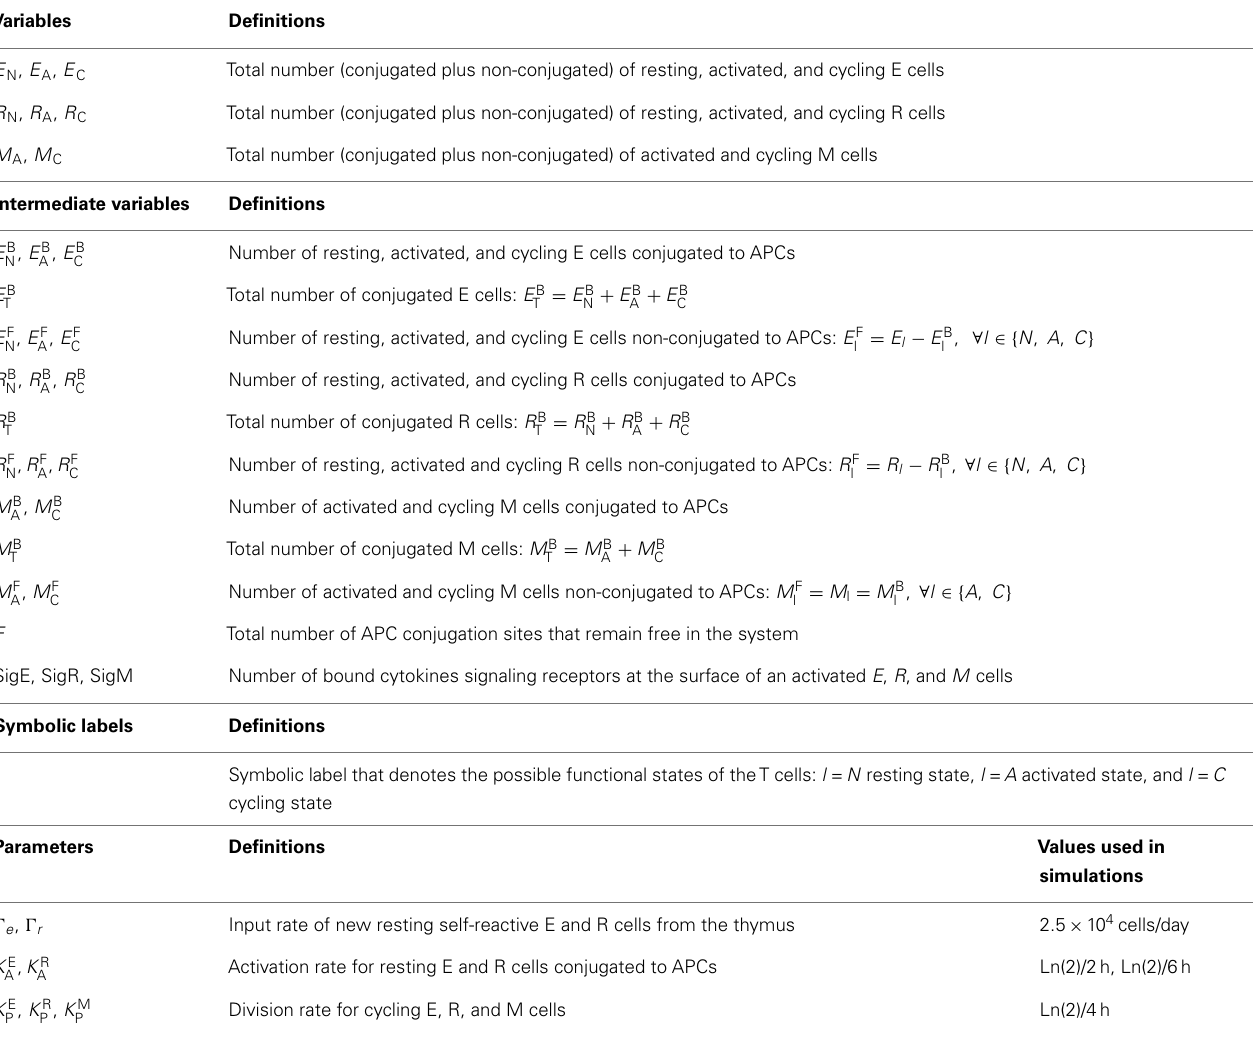
Table 2 |Variables and parameters appearing in the equations that model theT cells